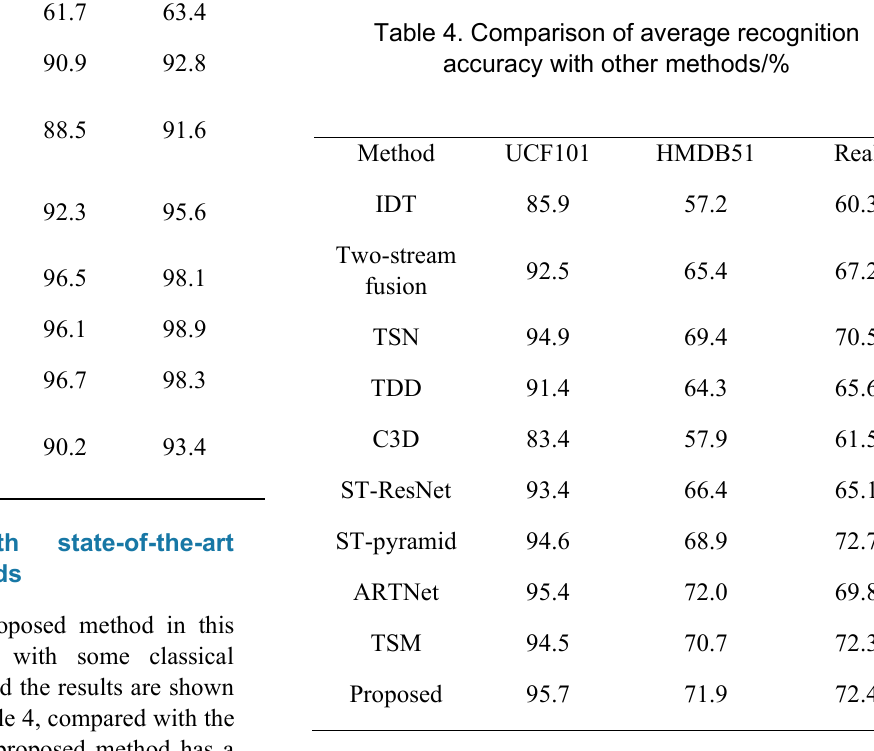
Table 4. Comparison of average